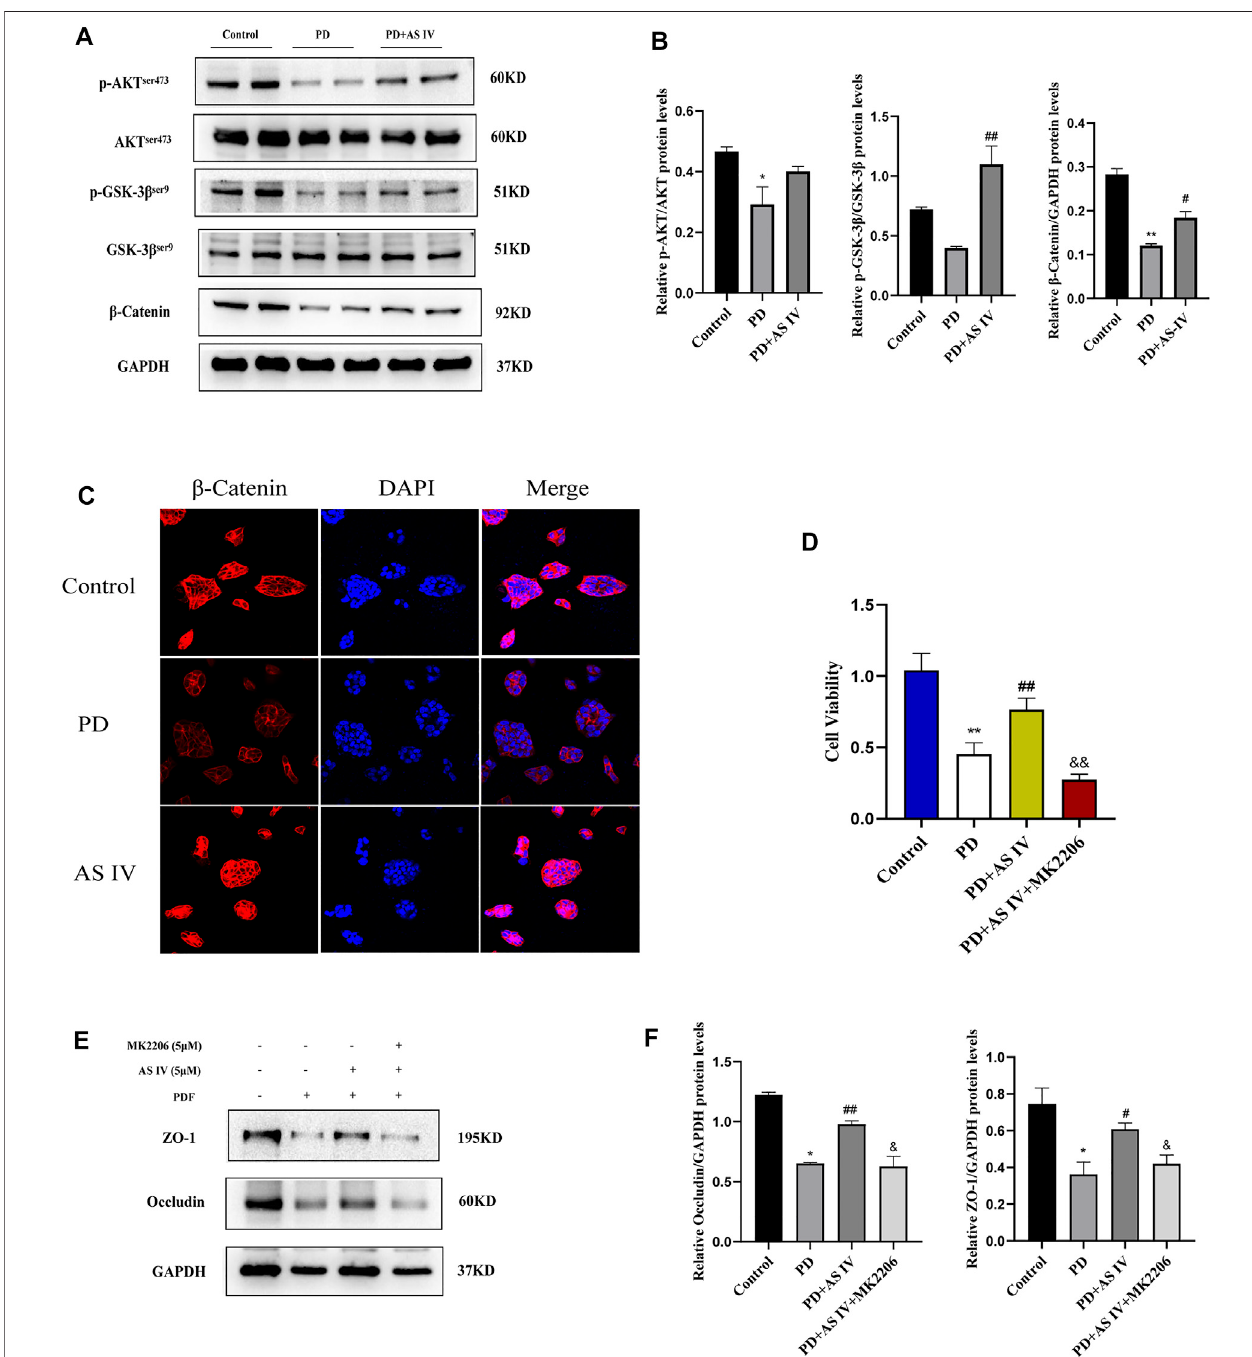
FIGURE 5 | AS IV protected against PD-induced intestinal epithelium damage by activating AKT/GSK3 β / β -catenin pathway in T84 cells (A,B) T84 cells were incubated with PDF and AS IV (5 μ M), then protein expression levels of AKT, p-AKT, GSK-3 β , p-GSK3 β and β -catenin were evaluated by western blotting (C) The distribution and expression of β -catenin were determined by immuno fl uorescence assay (D) T84 cells were incubated with PDF, AS IV (5 μ M) and MK2206 (5 μ M), then cell viability was calculated by CCK-8 (E,F) After the indicated treatments in T84 cells, the protein expression levels of occludin and ZO-1 was determined by western blotting. Data are presented as means ± SD of three independent experiments. * p < 0.05 or ** p < 0.01 versus the control group. # p < 0.05 or ## p < 0.01 versus the PD group.